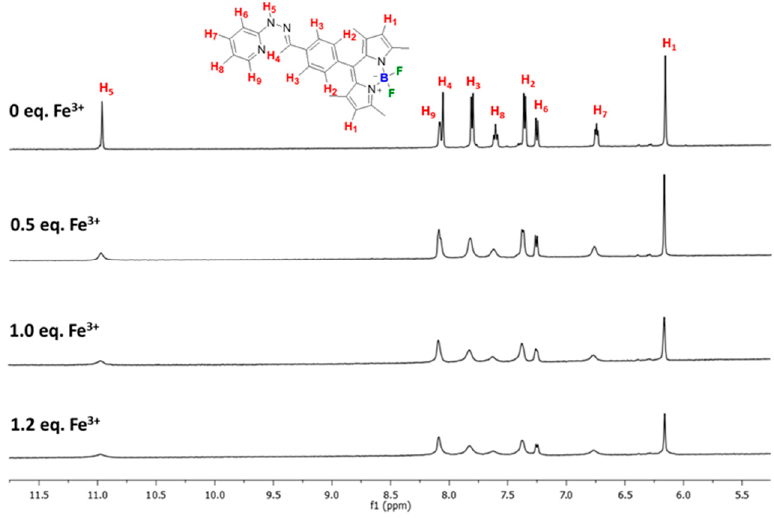
Figure 7. 1 H NMR (500 MHz) spectra of BODIPY-PH in the presence of Fe 3+ in DMSO-d 6 . FT-IR spectroscopy was also carried out to confirm the complex formation between Fe 3+ and BODIPY-PH (Figure 8). For the BODIPY-PH spectrum, the characteristic peaks at 3181, 2978, 2926, 1597, and 1584 cm − 1 were assigned to N—H, C methyl —H, C methyl —H, C=N, and C=N stretching vibrations, respectively. It was observed that the wavenumbers of the N—H and C=N peaks were found at the lower frequencies than those values reported in the literature [55,56], due to the larger conjugation length. After complex formation, the broad and intense O—H peak at 3231 cm − 1 regarding the H 2 O ligands that coordinated to the Fe 3+ was detected. Moreover, the C=N peaks of the BODIPY-PH-Fe 3+ complex were enlarged and shifted toward the lower wavenumbers (1551, 1524 cm − 1 ) compared to those of BODIPY-PH. This suggested that the Schiff base nitrogen was likely to coordinate with the Fe 3+ ions [57] which is agreeable with the result from NMR spectroscopic technique. Figure 8. Fourier transform infrared spectroscopy (FTIR) spectra of BODIPY-PH (blue line) and BODIPY-PH-Fe 3+ (red line). In addition, the limit of detection (LOD) of BODIPY-PH was calculated from the plots of the increased fluorescence intensities and the Fe 3+ concentrations, as demonstrated in Figure S5 by using 3 σ / m formula, where σ is the standard deviation of fluorescence signals of the chemosensor without analyte and m is the slopes of the plots. The LOD of BODIPY- PH was estimated as 0.58 µM, which was slightly higher than that of other reported BOD- IPY-based Fe 3+ sensors A and B and considerably higher than that of C (Table 1 and the